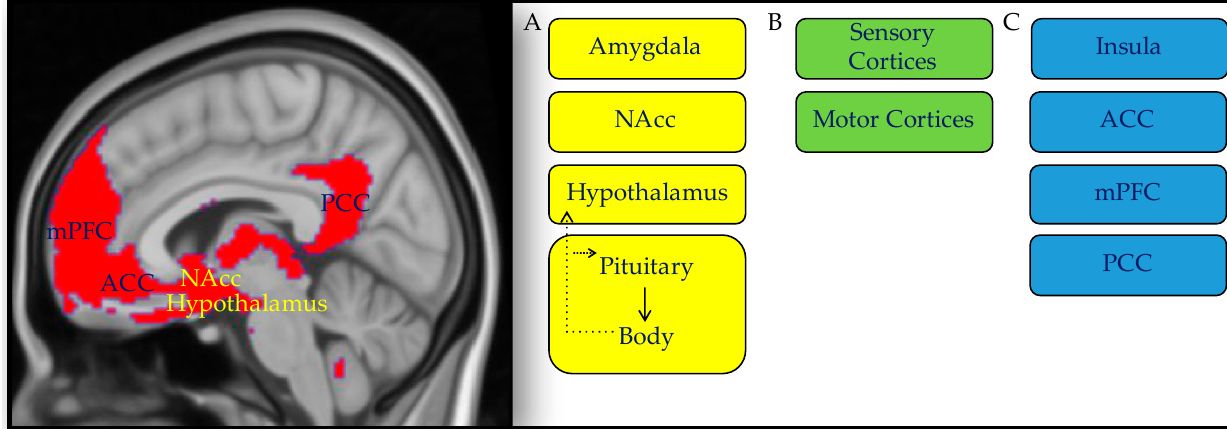
Figure 1. Domain-general neural circuits support social processing. Social processing in the brain does not rely on dedicated tissue, but on domain-general circuits that control allostasis, and multi-modal integration, including: ( A ) Visceromo- tor circuits that control allostasis, including, the amygdala, nucleus accumbens (NAcc), hypothalamus, and pituitary (in yellow) [71]; ( B ) Cortices of perception and action that perceive the environment and control behavior (in green); ( C ) Association cortices including limbic cortices in the anterior cingulate cortex (ACC) and insula, as well as the medial prefrontal cortex (mPFC) and posterior cingulate cortex (PCC) [81]. With experience, association cortices integrate multi- modal information and represent it as concepts, including emotion concepts and concepts about the mind of others [30,64] (in blue). Altered function in these circuits, which characterizes individuals with autism [82–84], supports the domain- general view of autism.